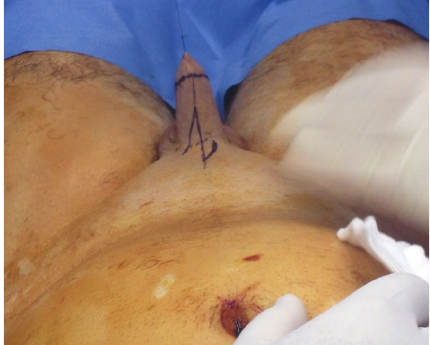
Figure 4: The distal skin tubularised over 14 Fr